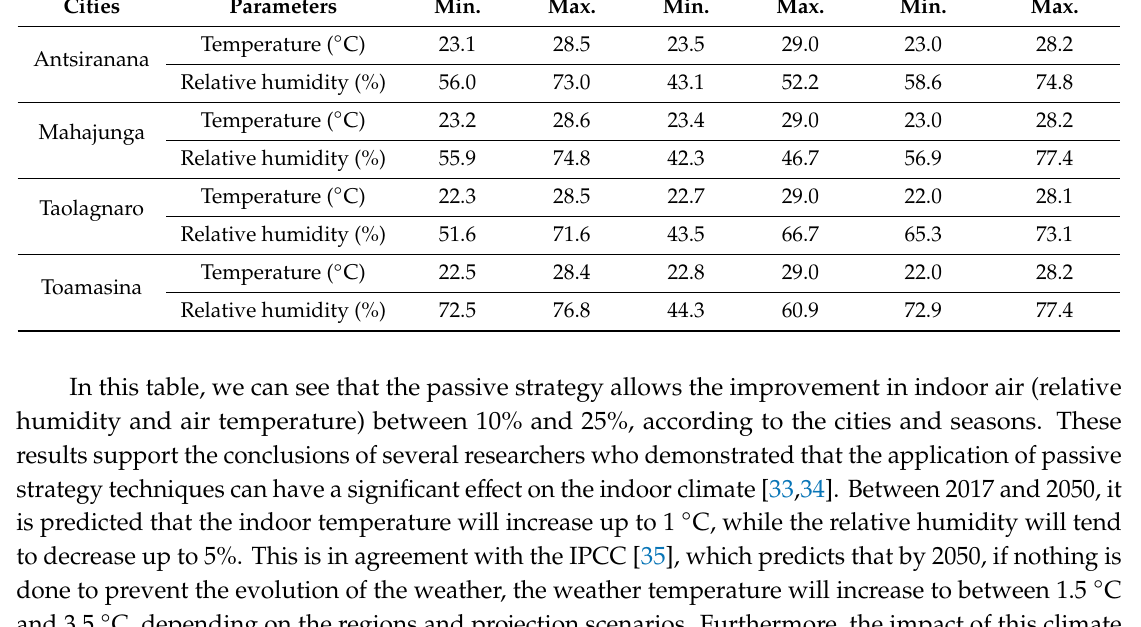
Table 4. Average indoor adaptive comfort in the di ff erent selected cities with 90% acceptability Range. No Strategy 2050 With Passive Strategies Cities Parameters Min. Max. Min. Max. Min. Max. Temperature ( ◦ C) 23.1